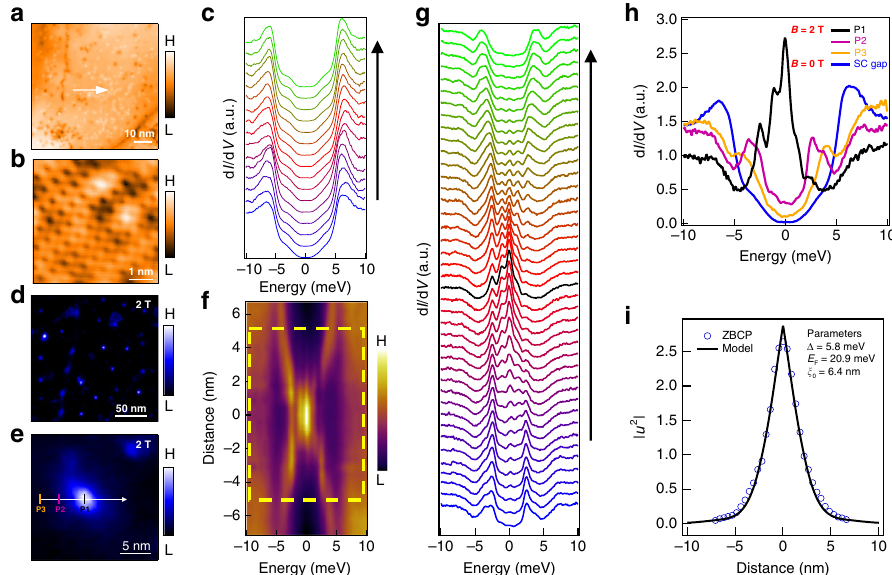
Fig. 3 MZM in a topological vortex core. a STM topography of CaKFe 4 As 4 (scanning area: 70nm × 70nm). b Atom-resolved topography within the area of 5 × 5 nm 2 . c STS spectra taken along the white arrow in a , at T = 0.45K and B = 0 T. The direction of waterfall-like spectra plot is indicated by the black arrow. d Zero-bias conductance map measured at a magnetic fi eld of 2T in the area as shown in a . e Zero-bias conductance map (area: 20nm× 20nm) around a vortex core at T = 0.45K and B = 2 T, the white arrows in a , e indicate the same position. f Intensity plot of d I /d V spectra along the white arrow across the vortex in e . g Waterfall-like d I /d V spectra plot within the yellow dashed box in f , with the black curve representing the spectrum at the vortex core center, and the black arrow indicates the direction of the plot. h Comparison of d I /d V spectra at vortex core (P1), middle (P2), edge (P3), and without magnetic fi eld (SC gap). The “ SC gap ” spectrum is the lowest spectrum in c and measured at the same position of P3. All spatial positions are marked in e . i Comparison between the spatial dependence of the ZBCP peak height with a theoretical calculation of the MZM spatial pro fi le (to exclude the in fl uence of CBSs and background, each d I /d V spectrum is fi tted by multi-Gaussian peaks to extract the height of ZBCP. An example of a fi t is shown in Fig.